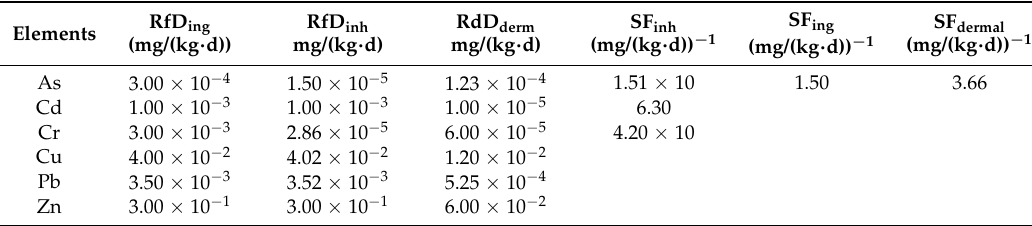
Table 2. Reference doses (RfD) and slope factors (SF) for HRA of PTEs pollution [38]. Subscripts: ing = ingestion; inh = inhalation; derm = dermal